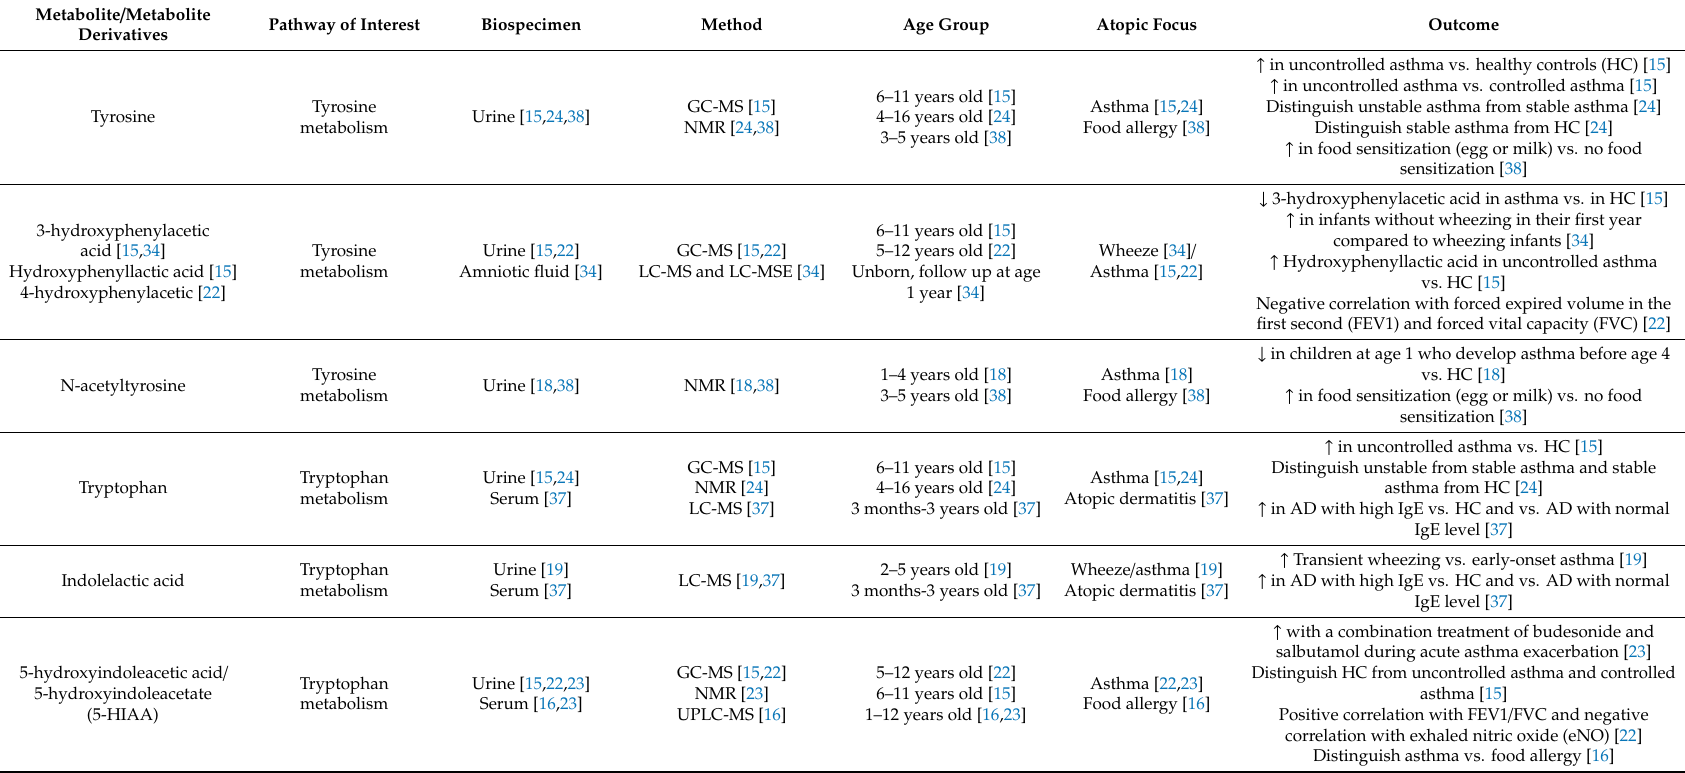
Table 2. Metabolites within pathways of interest identified as significant in more than one